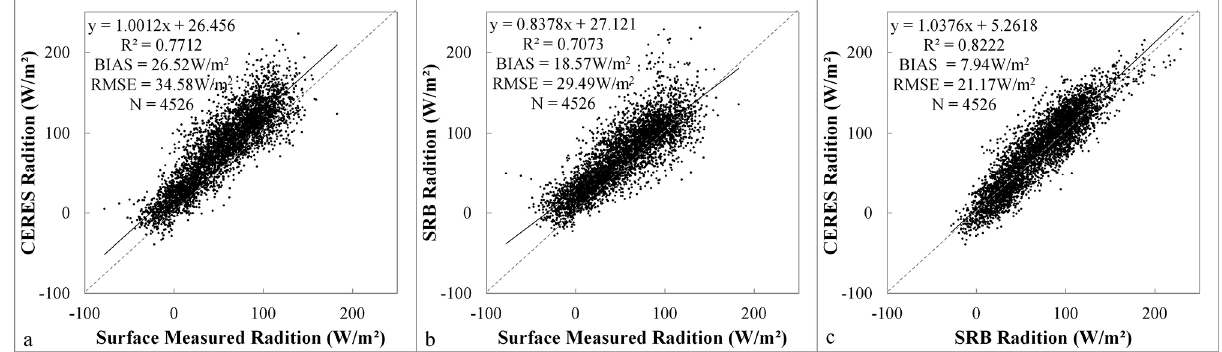
Figure 2. Comparison of monthly net radiation derived from the CERES and the SRB products with surface observations at 50 meteorological sites in China. ( a ) Surface observations versus CERES data; ( b ) surface observations versus SRB data; and ( c ) SRB versus